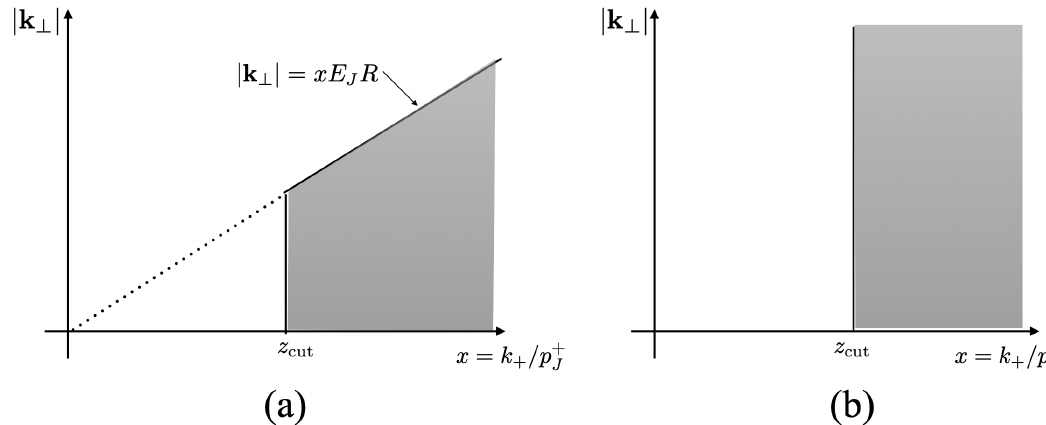
Figure 7 . (a): phase space for a radiated gluon in S . Here the shaded region is the inner J G /Q space of the groomed jet and the contribution is proportional to δ (1 − z ) . The contributions with z 6 = 1 comes from the outside of the shaded region. (b): the phase space for the ucsoft gluon scaling as p ucs ∼ z cut E J (1 , m/E J , ( m/E J ) 2 ) , which is decoupled from the csoft mode when we consider the limit E J R (cid:29) m